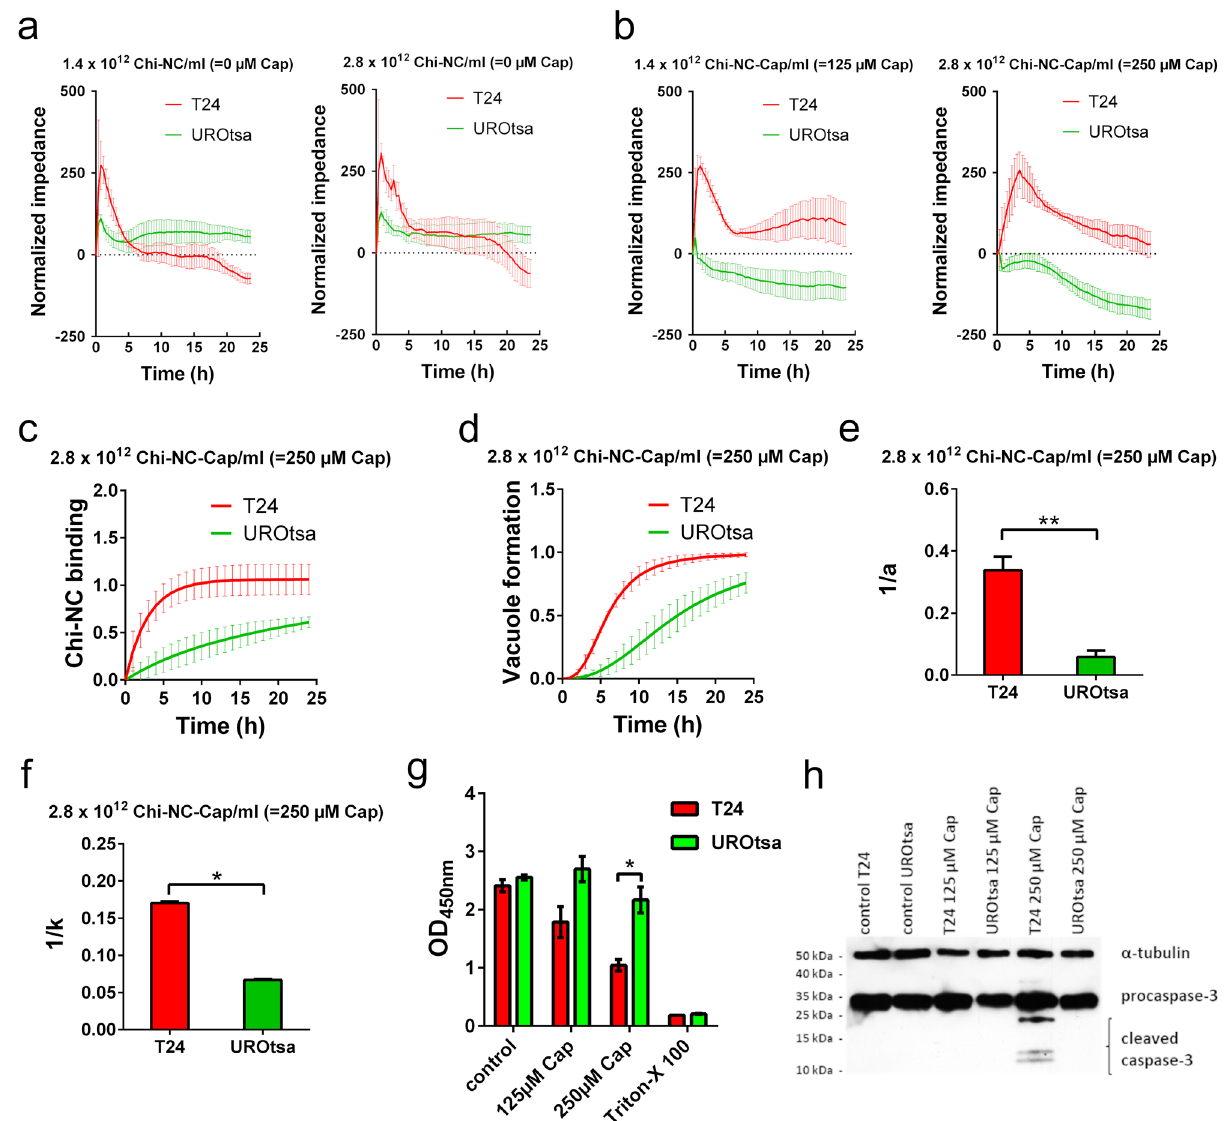
Figure 5. Impedance measurements of T24 and UROtsa cells following treatment with capsaicin-loaded or empty Chi-NCs. ( a ) Control experiments with empty Chi-NCs (no capsaicin) at indicated nanoparticle concentrations (2.8 × 10 12 and 1.4 × 10 12 particles mL −1 ). Data are presented as mean ± SD ( n = 4). ( b ) Treatment with capsaicin-loaded Chi-NCs (Chi-NC-Cap) at indicated concentrations (2.8 × 10 12 particles mL −1 = 250 µm capsaicin, and 1.4 × 10 12 particles mL −1 = 125 µm capsaicin). The response of T24 cells was more pronounced than that of UROtsa cells. Data are presented as mean ± SD ( n = 4). ( c ) Binding of Chi-NC-Cap as a function of time (2.8 × 10 12 particles mL −1 = 250 µm capsaicin). Data are presented as mean ± SD ( n = 3). ( d ) Vacuole formation as a function of time upon treatment with Chi-NC-Cap (2.8 × 10 12 particles mL −1 = 250 µm capsaicin). Data are presented as mean ± SD ( n = 3). ( e ) Derived from ( c ), ability of cells to bind Chi-NC-Cap ( a − 1 ). Data are presented as mean ± SD ( n = 3, ** p < 0.01). ( f ) Derived from ( d ), ability of T24 and UROtsa cells to deposit capsaicin in vacuoles ( k − 1 ). Data are presented as mean ± SD ( n = 3, * p < 0.05). ( g ) Viability of Chi-NC-Cap treated T24 and UROtsa cells (2.8 × 10 12 particles mL -1 = 250 µm capsaicin, and 1.4 × 10 12 particles mL −1 = 125 µm capsaicin) was measured by WST-1 assay. RPMI-1640 medium (control) and 1% v/v Triton-X 100 were used as reference. Data are presented as mean ± SD ( n = 3, * p < 0.05) ( h ) Detection of procaspase-3, cleaved caspase-3 and α-tubulin by western blot in lysates of cells treated with Chi-NC-Cap (1.4 × 10 12 particles mL −1 = 125 µm capsaicin and 2.8 × 10 12 particles mL −1 = 250 µm capsaicin). The unprocessed western blot image is shown in Supplementary Fig.